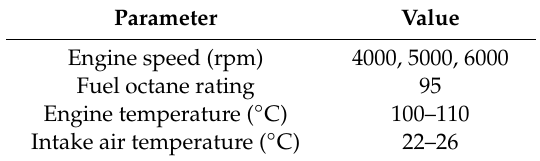
Figure 1. Schematic of this experiment and setup location. Figure 3. Photographic view of the device set up on ( a ) model A and ( b ) model B of the experimental motorcycle.